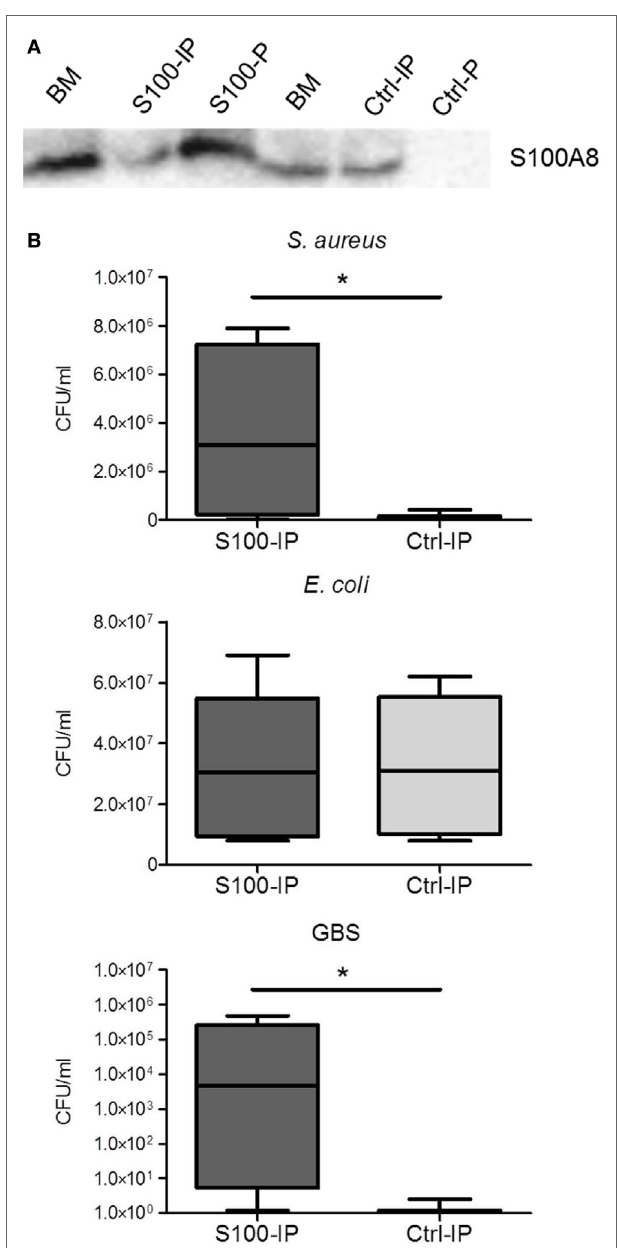
FigUre 6 | Depletion of S100A8/A9 decreases the antimicrobial activity of breast milk (BM). (a) Efficiency of S100A8/A9 removal was determined by immunoblotting against S100A8. Representative blot showing BM probes before and after S100-IP and control (Ctrl)-IP as well as the precipitates (S100-P and Ctrl-P). (B) Staphylococcus aureus , Escherichia coli , and group B streptococci (GBS) were grown over 24 h in S100A8/A9-depleted (S100-IP) and non-depleted (Ctrl-IP) BM samples. Box plots show medians (center lines) and interquartile ranges of the concentration of colony-forming units (CFU) ± SEM. * p < 0.05, t